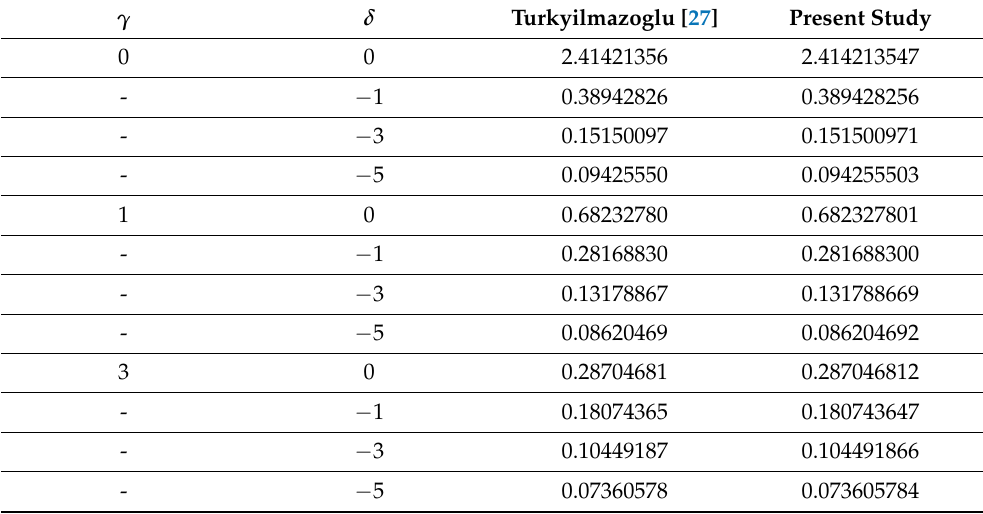
Table 3. Comparison values of − f (cid:48)(cid:48) ( 0 ) with existing works when ϕ 1 = 0 = ϕ 2 = k 1 , λ = 1, s =